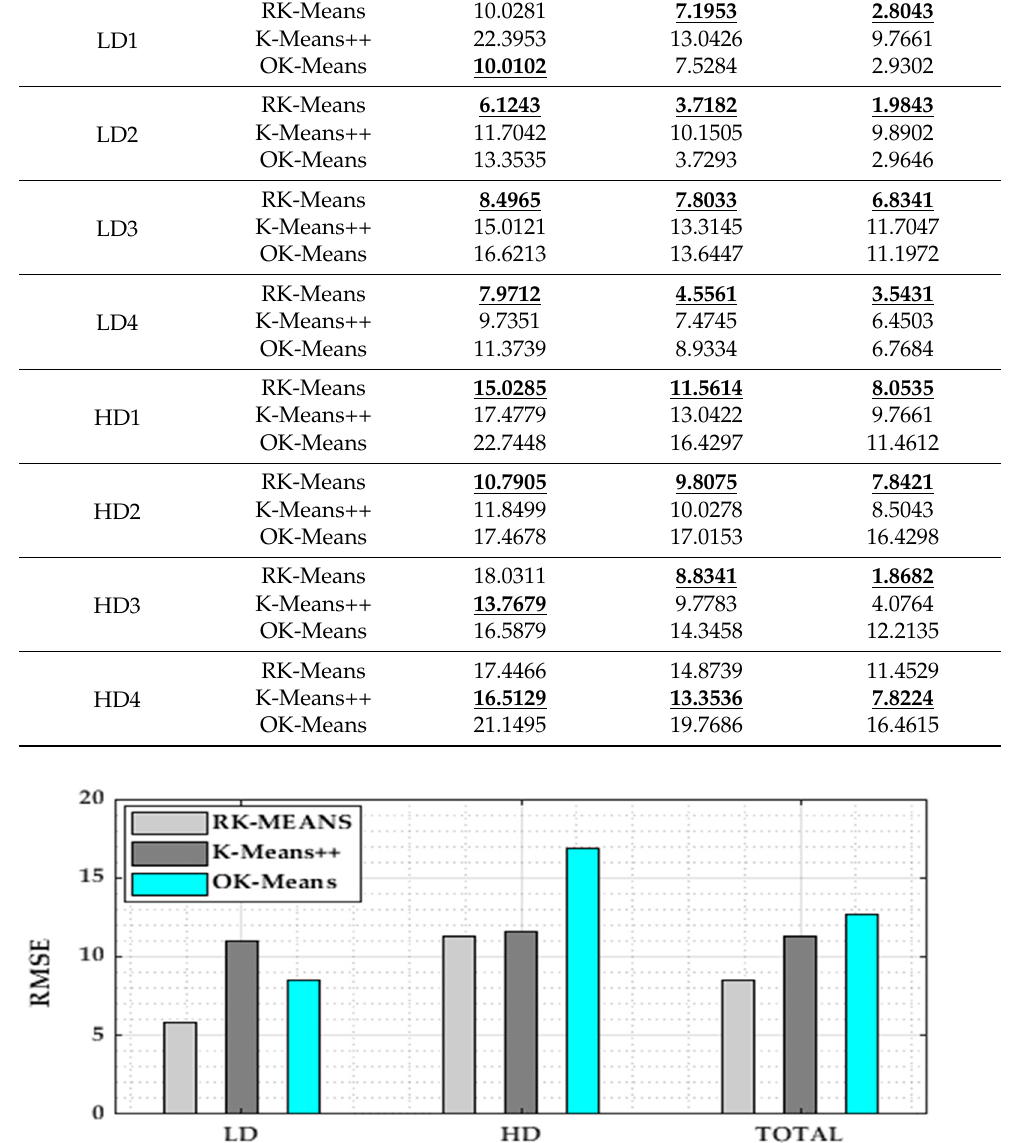
Figure 12. RMSE comparison results.